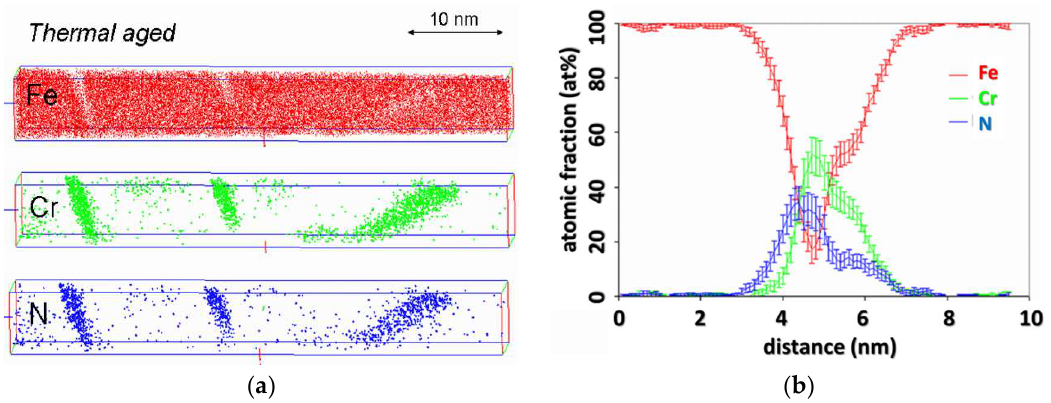
Figure 10. ( a ) Atom probe tomography (APT) tomogram and ( b ) corresponding composition profile ( b ) of nitride platelet in nitrided Fe-5at.% Cr alloy followed by thermal treatment in vacuum for 24 h at 590 °C.